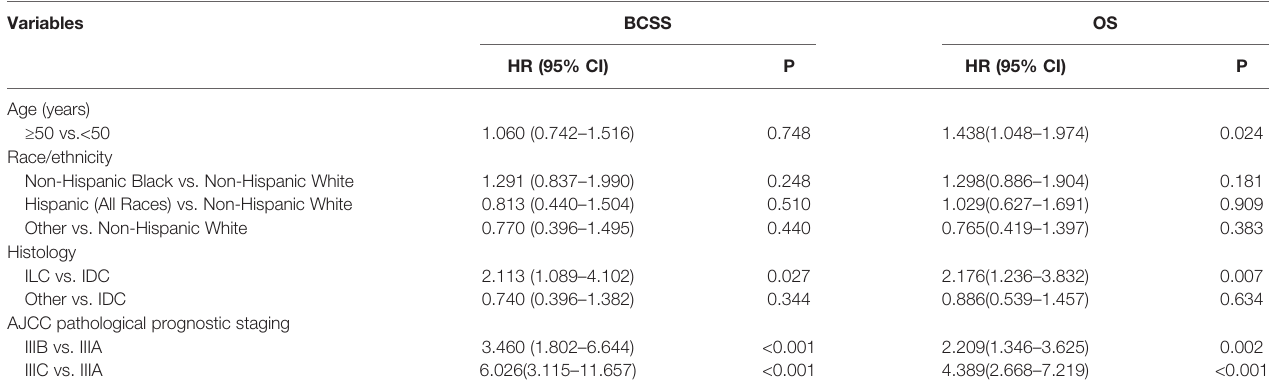
TABLE 4 | Multivariate analysis of prognostic factors using the Cox-regression model (including 8th AJCC pathological prognostic staging).